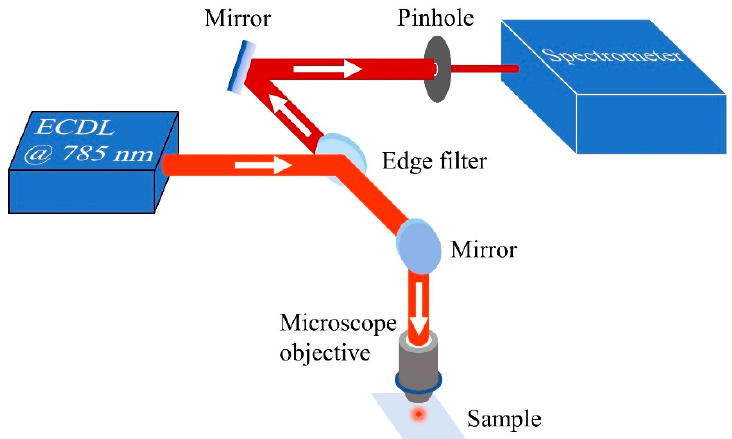
Figure 3. Experimental setup of shifted excitation Raman difference spectroscopy (SERDS) for spore measurements. The microscope objective focuses light emitted from a homemade external cavity diode laser (ECDL) onto the sample, generating red-shifted Raman signals that propagate backward along the laser beam path. The signals are subsequently transmitted through the edge filter and detected by the spectrometer. Refer to [71,72] for more parameter settings in the SERDS measurements.